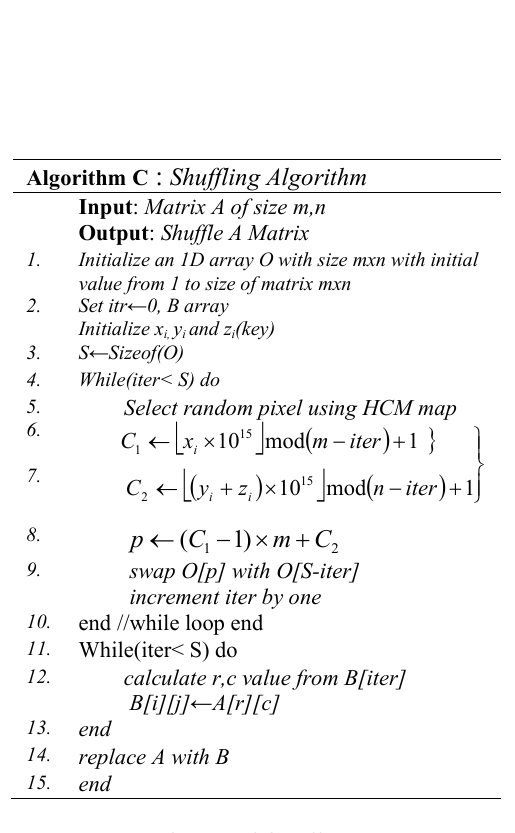
Fig 6. The block diagram of (a) Encryption process, (b) Decryption process